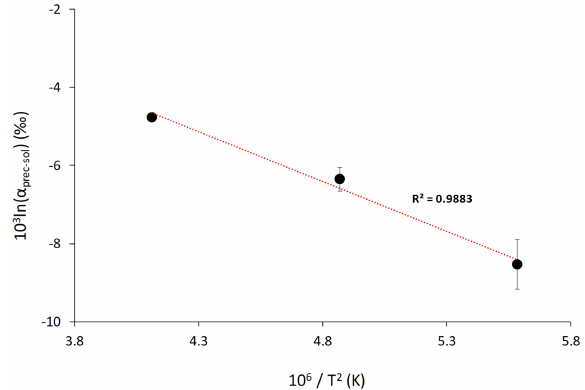
Figure 4. Lithium isotope fractionation factor as a function of the reaction temperature, T (in K). Average values for each tempera- ture are shown. The dotted line shows the linear regression through these values according to Eq. (3). Error is not shown for the iso- tope fractionation factor at 220 ◦ C because no repeat analysis was performed.